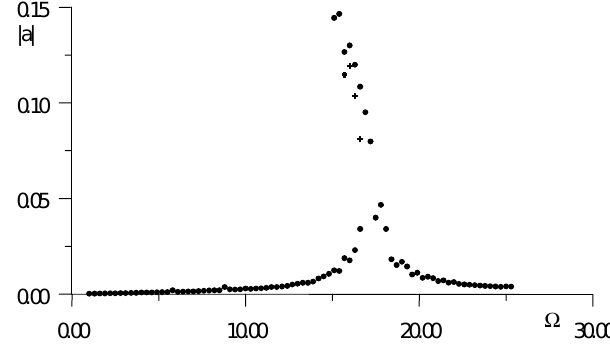
Fig. 4. Typical resonance curve for F = 0.01 N – softening